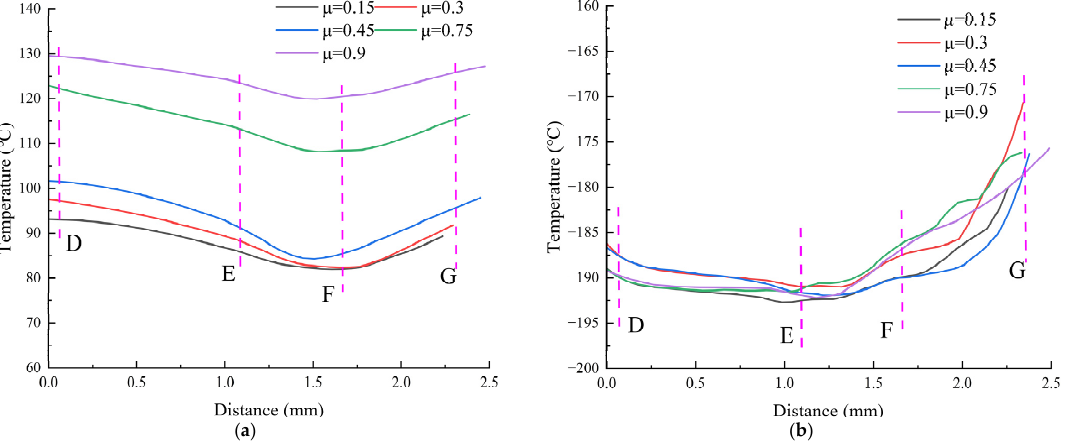
Figure 19. Variation curves of temperature of the fins along the trajectory direction under different conditions: ( a ): RT-EM; ( b ):